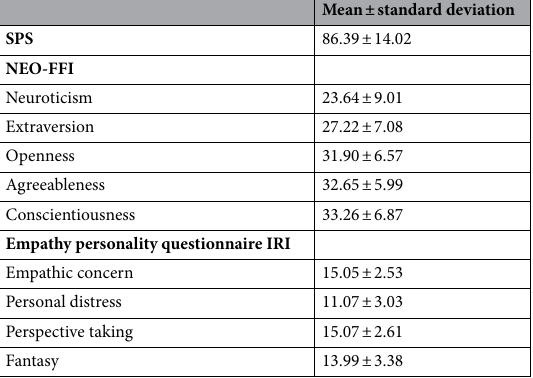
Table 1. Results of personality questionnaires HSPS, IRI, and